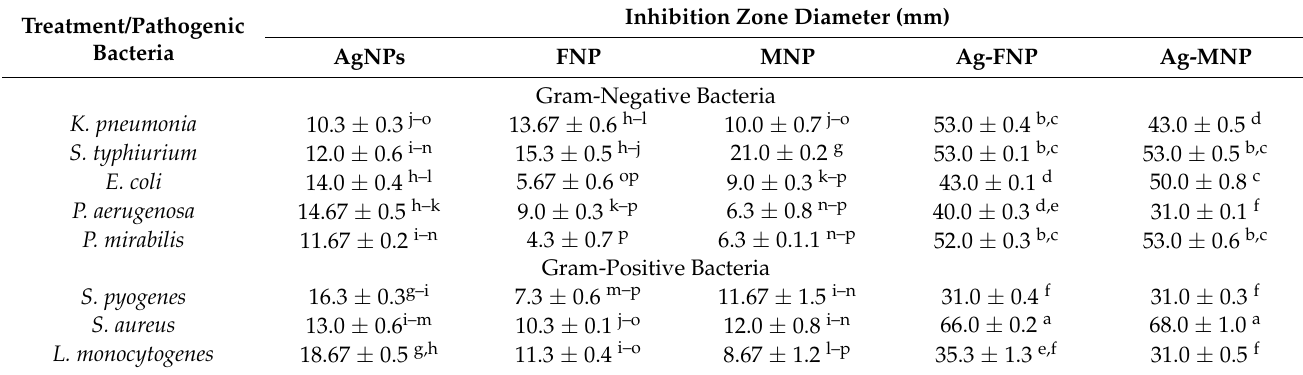
Table 1. Antibacterial activity of (at 1 MIC) AgNPs, FNP, MNP, Ag-FNP, and Ag-MNP. Treatment/Pathogenic